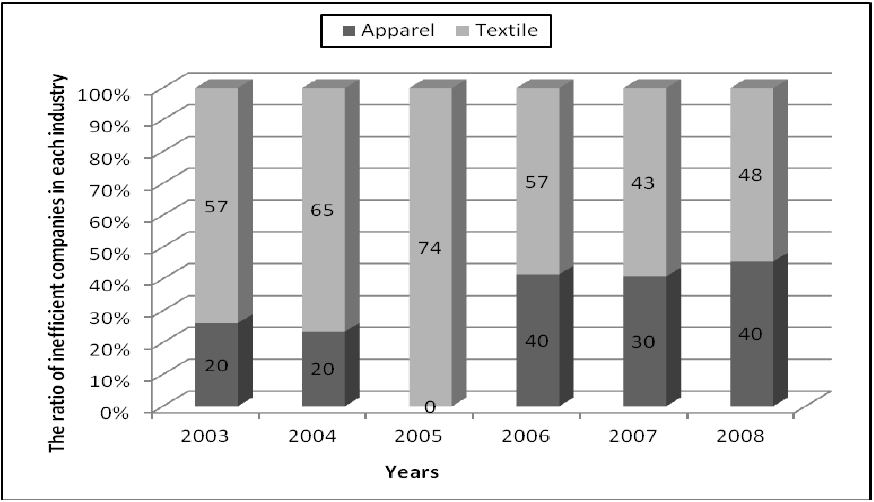
Figure 1. The ratio of inefficient companies within each